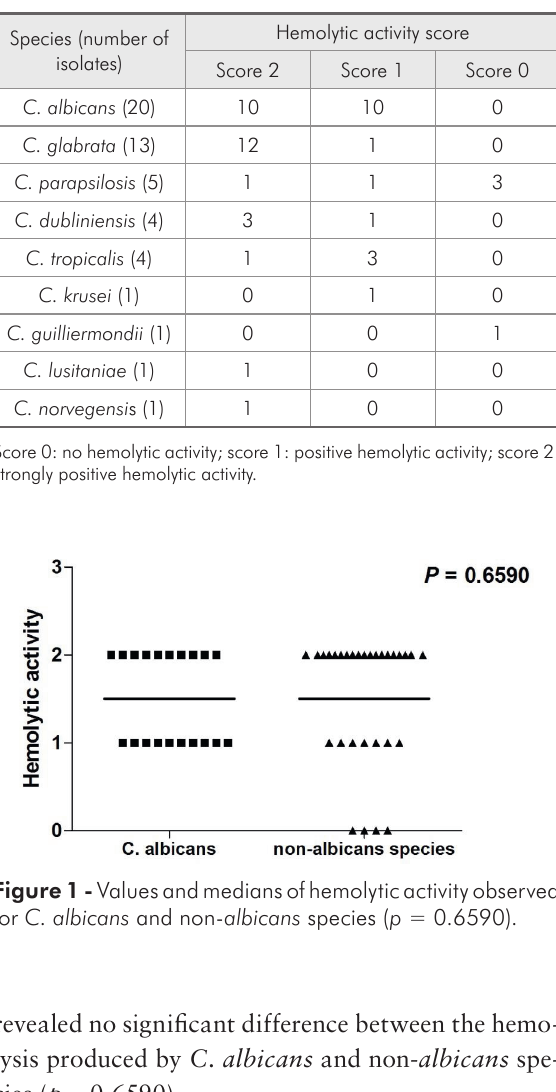
Table 2 - Distribution of Candida species according to he- molytic activity